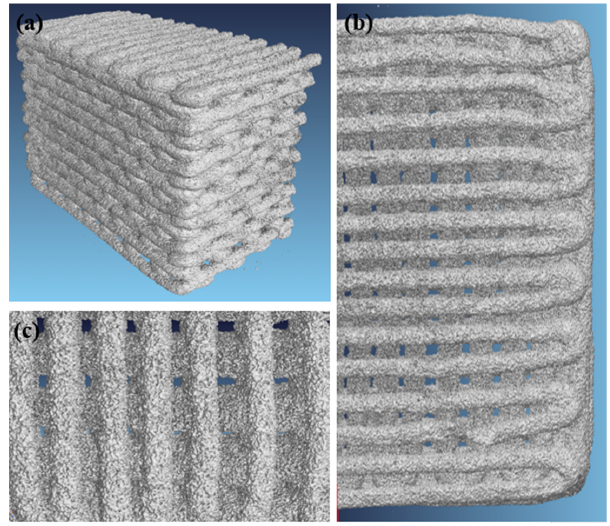
Figure 5. 3D reconstruction of the sca ff old volume by µ CT analysis: ( a ) lateral view; ( b ) top view; ( c ) highlight of the change in rod spacing in the central zone of the sca ff old (nominal rod diameter: 300 µ